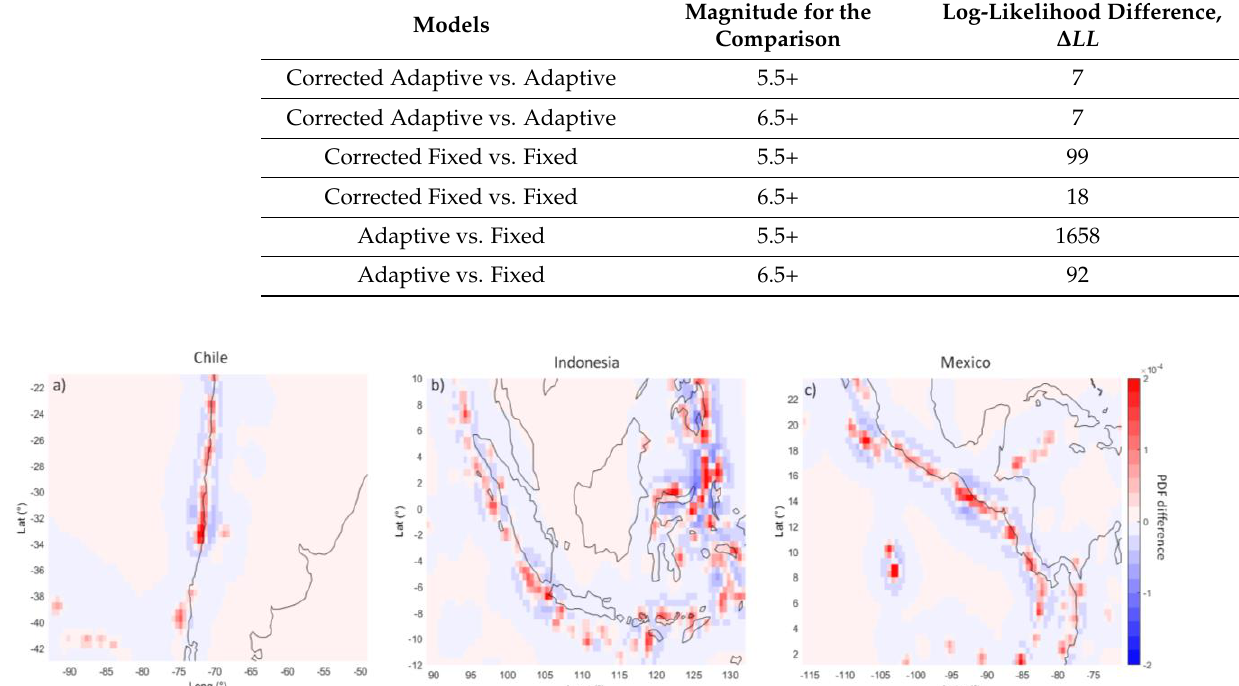
Table 5. Log-likelihood differences ( ∆ LL ) between the models.